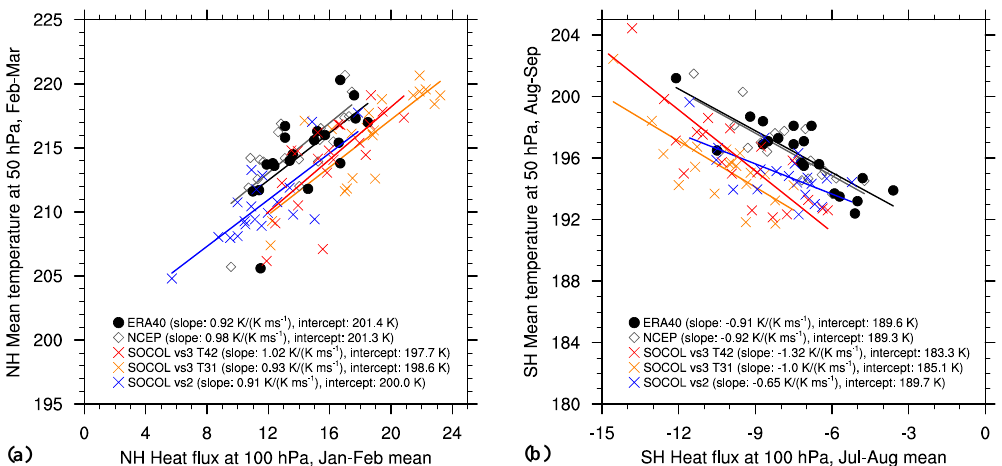
Fig. 4. (a) Heat fluxes ( v 0 T 0 ) [Kms − 1 ] at 100hPa (averaged over 40 ◦ N to 80 ◦ N for January and February) versus temperatures [K] at 50hPa (averaged over 60 ◦ N to 90 ◦ N for February and March). Shown are 20 yr from 1980 to 1999 for SOCOLvs3 T42 (red), SOCOLvs3 (orange), SOCOLvs2 (blue), ERA-40 (black) and NCEP (grey) reanalyses. (b) Same for Southern Hemisphere with heat fluxes at 100hPa averaged over 40 ◦ S to 80 ◦ S for July and August versus temperatures at 50hPa averaged over 60 ◦ S to 90 ◦ S for August and September.